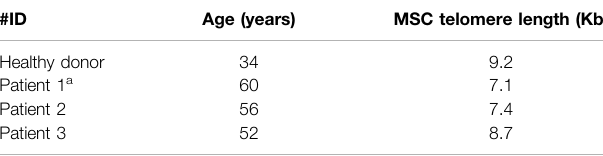
TABLE 6 | Telomere length by Southern blot